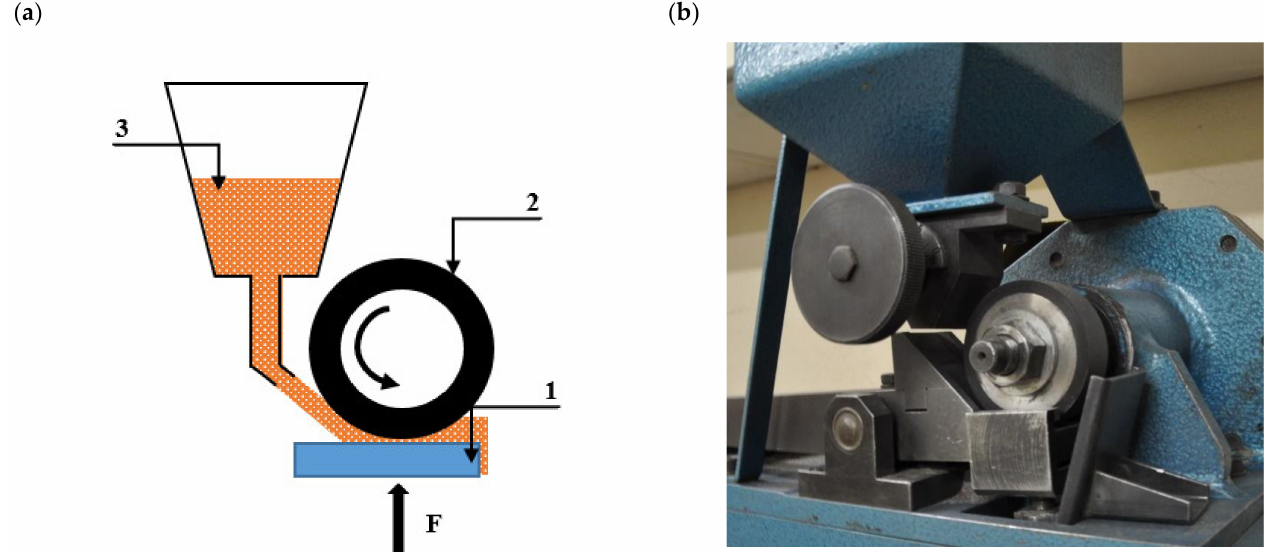
Figure 1. Schematic presentation of the test method ( a ), and the real image of the dry sand–rubber tester ( b ): l—specimen; 2—rubber-rimmed steel wheel; 3—hopper with abrader. The abrasive wear of the specimens was determined using the gravimetric